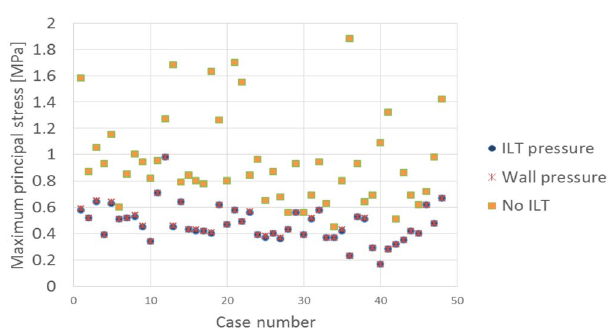
Figure 4. RPI distribution for case 2 used in reproducibility analysis. The results are obtained based on the segmentations performed by user A (right), B (center) and C (left). Despite the visual differences in geometry from user to user, the difference between the maximum RPI is ~5%.